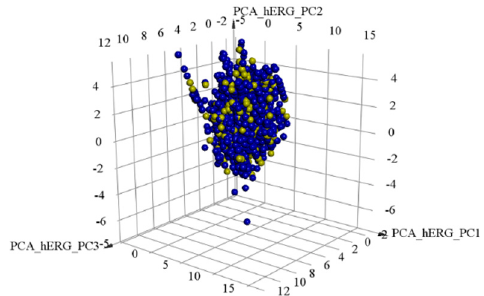
Figure 1. Principle component analysis (PCA) for the training and test sets of hERG blockers. Independent variables included partition coefficient (AlogP), molecular weight (MW), hydrogen-bond donor (HBD), hydrogen-bond acceptor (HBA), rotatable bond number (RBN), number of rings (Num Rings), number of aromatic rings (Num Arom Rings) and molecular fractional polar surface area (MFPSA). Blue and yellow spheres indicate training and test sets, respectively.